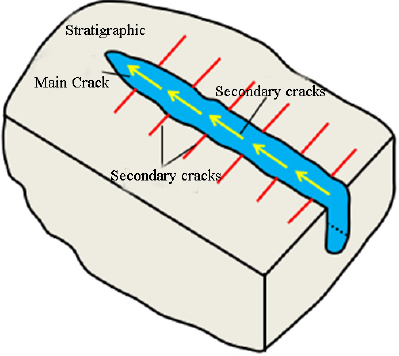
Figure 14. Sketch of the application of cryogenic fracturing for reservoir stimulation.